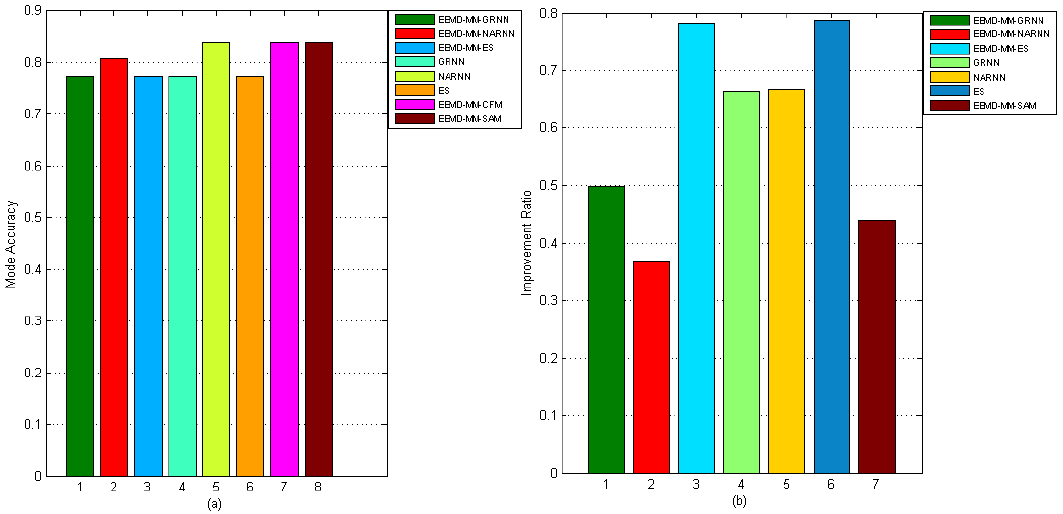
Figure 10. Performance comparison of different models in terms of MMA and